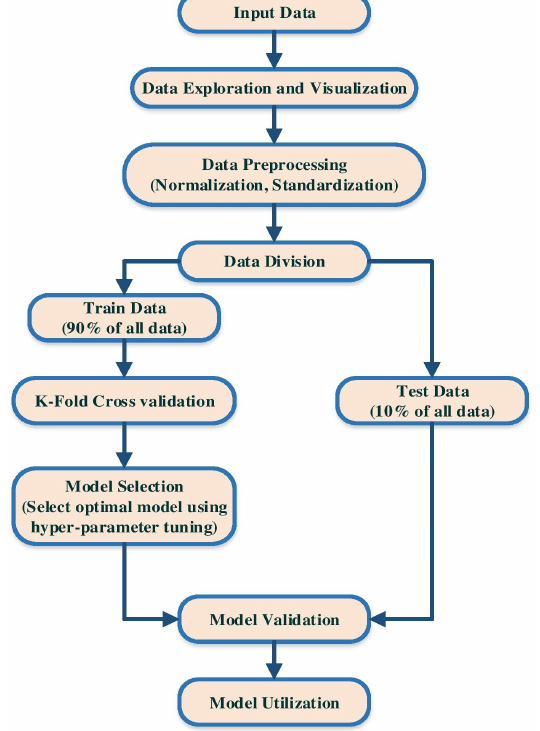
Figure 1. The Workflow of The Classification of Data of RC